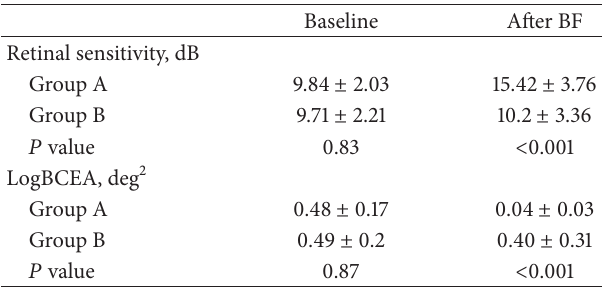
Table 1: Retinal sensitivity and bivariate contour ellipse area (BCEA) obtained in the two groups.